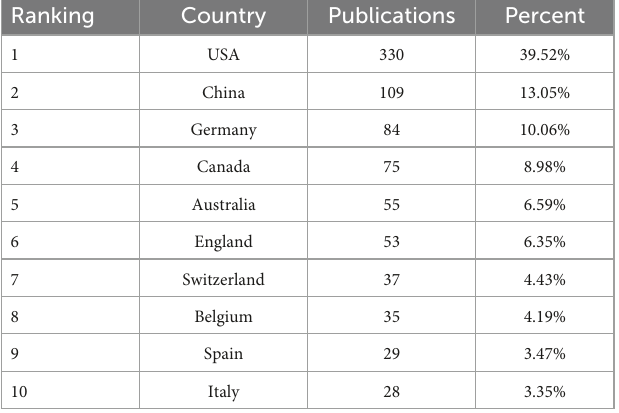
disorders ( n = 63) and frontiers in psychiatry ( n =